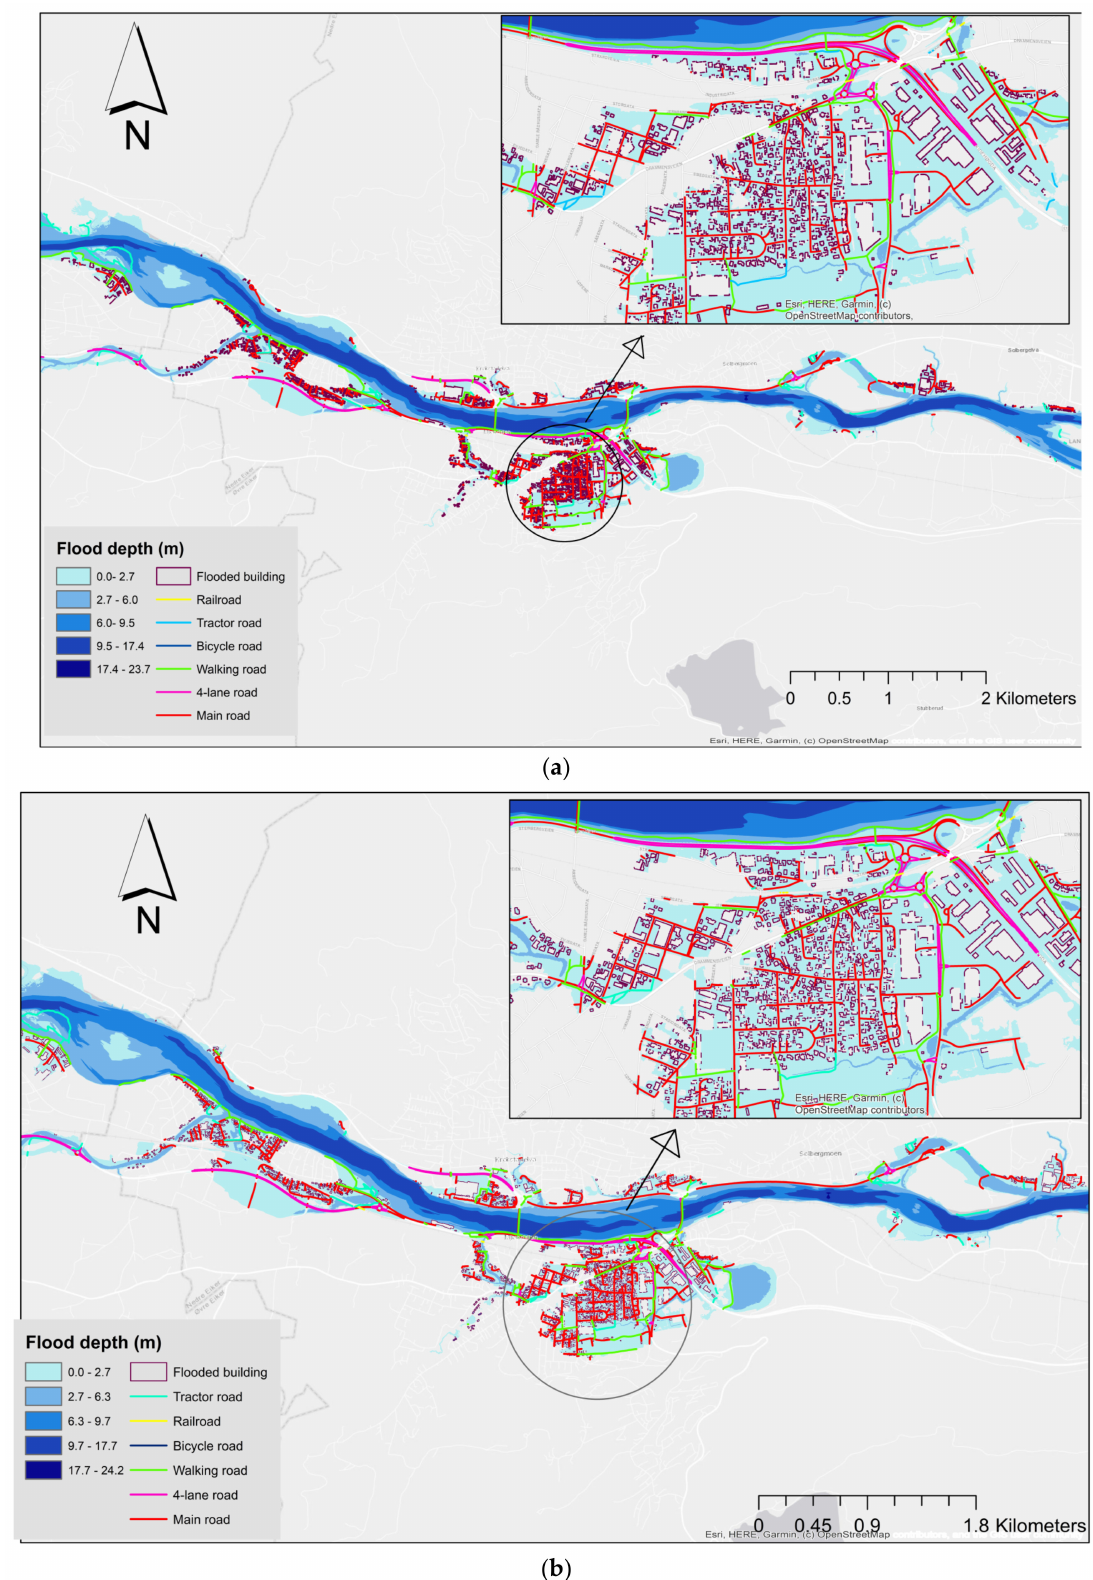
Figure 7. Water depth resulted from ( a ), Q200 current climate flood scenario ( b ), Q200 future climate flood